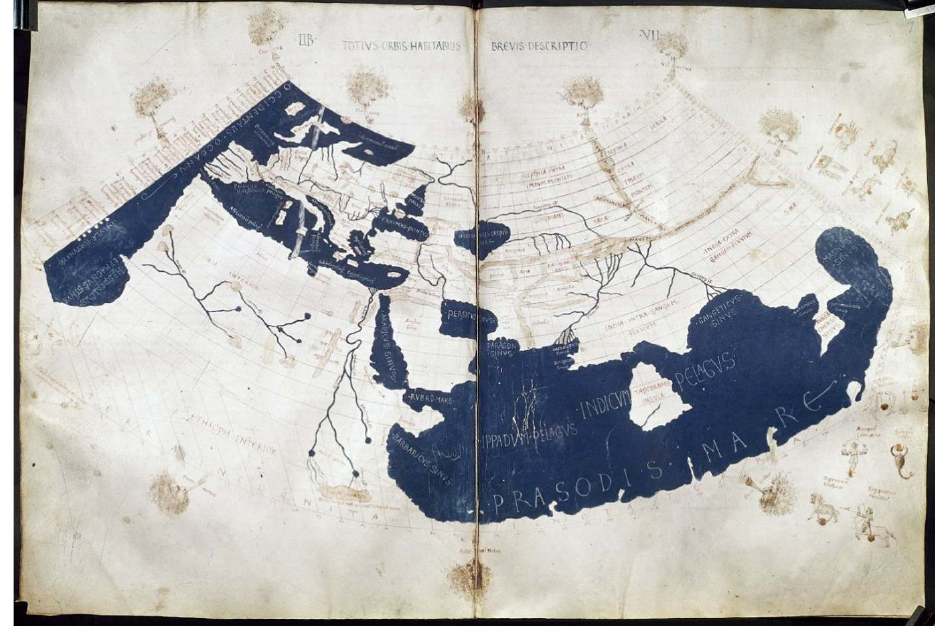
Figure 6. Ptolemy’s view of the Indian